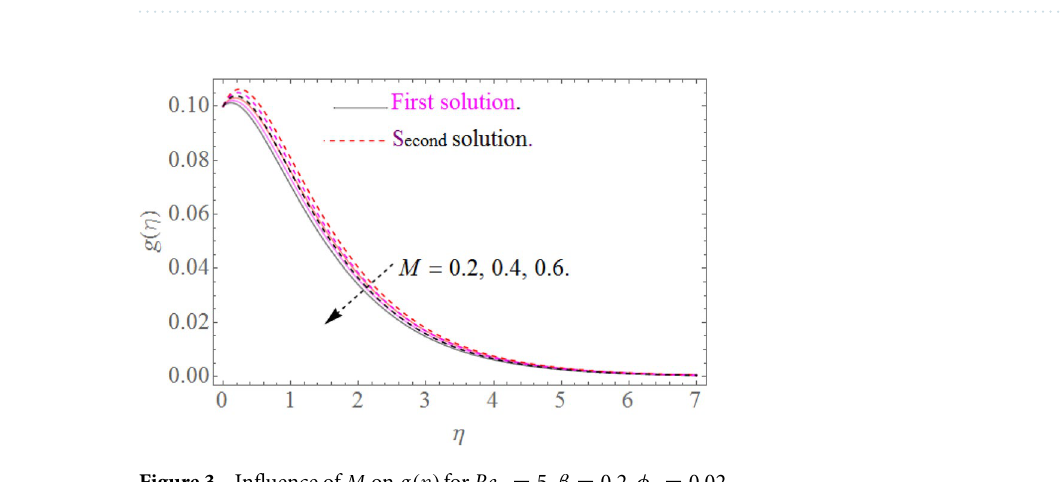
Figure 2. Influence of M on f ′ (η) for Re x = 5, β = 0.2, φ 2 = 0.02 .